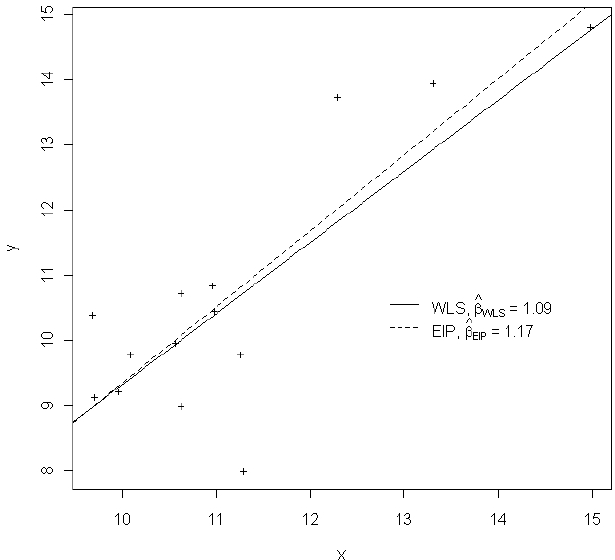
Fig. 1. The example data y versus x for the 14 ( x , y ) pairs, and lines depicting the WLS and EIP intercept and slope estimates.